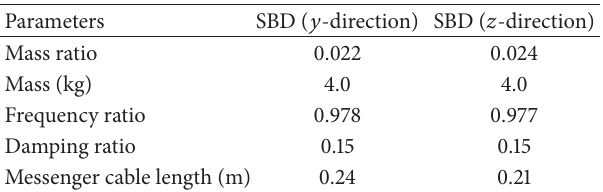
Table 4: Properties of